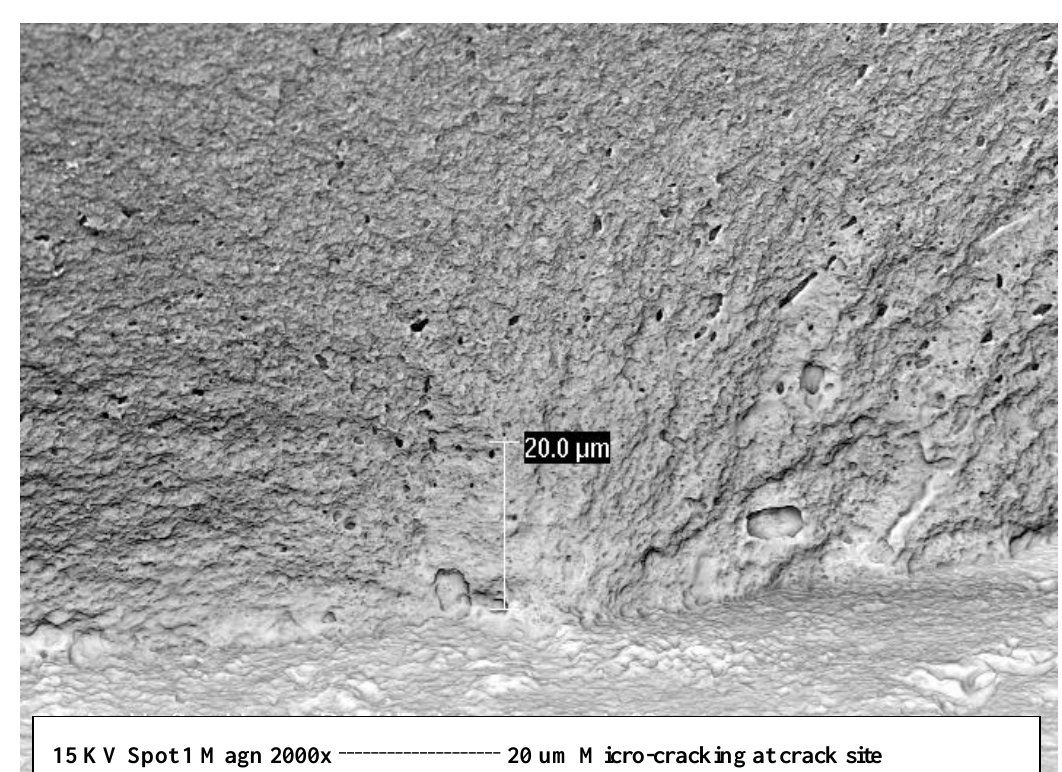
Figure 2. Secondary electron imaging, 1,000×, back scatter mode revealing micro-cracking appearing as black areas in the structure at location of failure